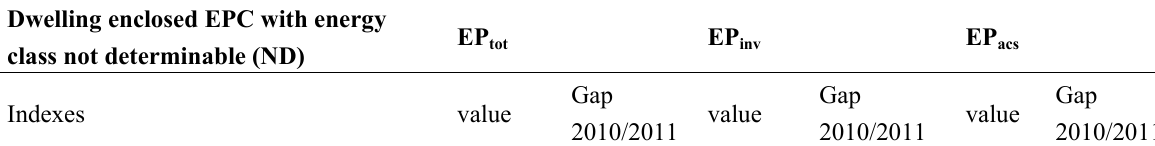
Table 15. Statistical data for database 2011 and gap between 2010 and 2011 database.